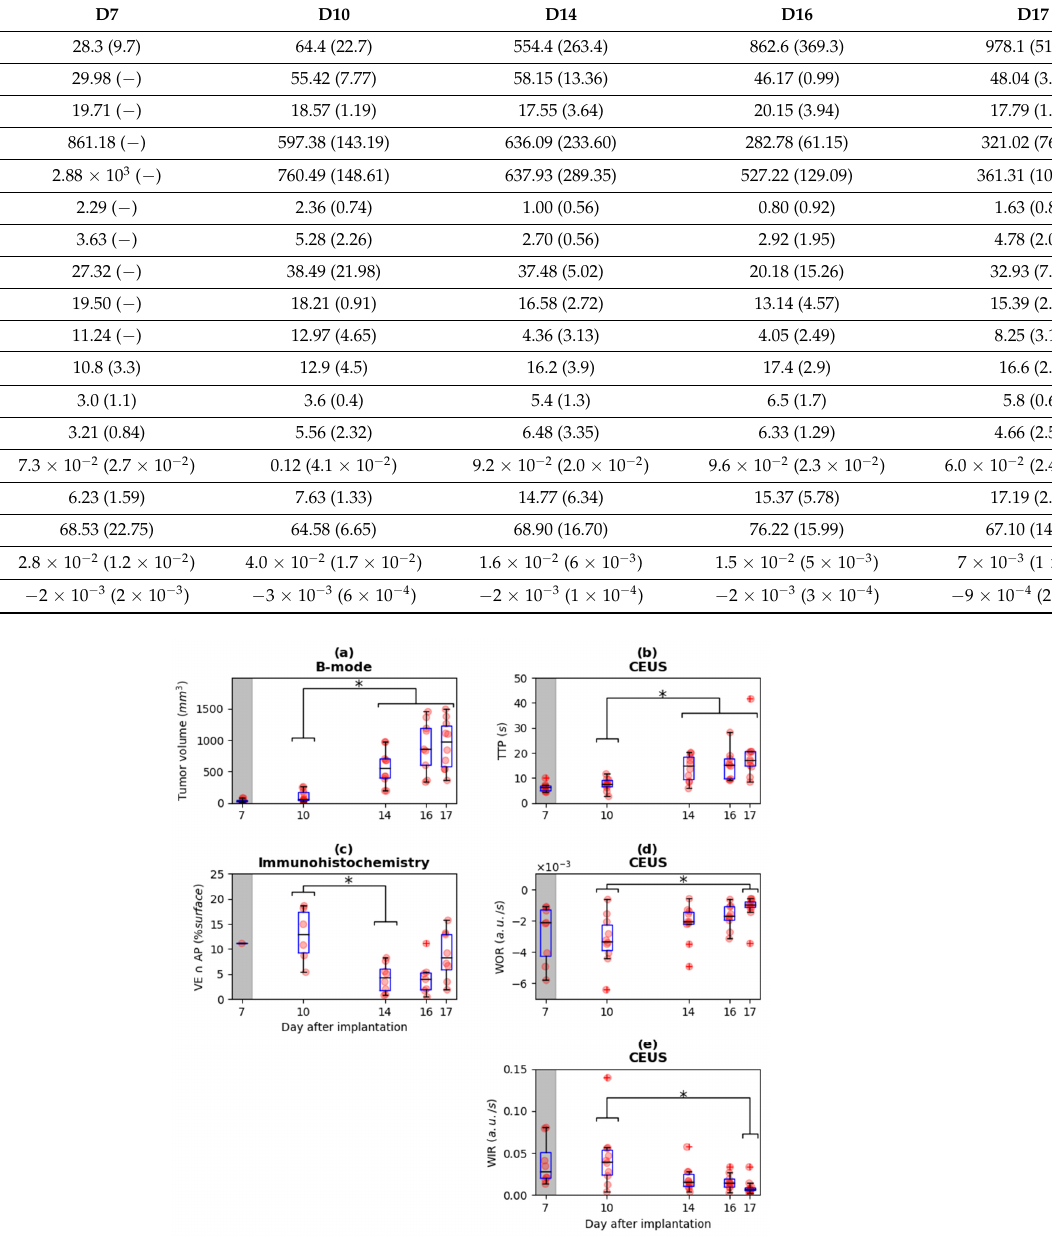
Figure 2. Evolution over time of ( a ) tumor volume, ( b ) Time To Peak (TTP), ( c ) colocalization of apoptosis and vascular endothelium (VE ∩ AP), ( d ) Wash-Out Rate (WOR), and ( e ) Wash-In Rate (WIR). For tumor volume ( a ) and the contrast parameters TTP ( b ), the values at D10 are significantly different to the values at D14, D16, and D17. The immunohistological parameter VE ∩ AP ( b ) shows significant difference between D10 and D14. The contrast parameters WOR ( d ) and WIR ( e ) show significant differences between D10 and D17. Initial measurements at D7 are shaded in grey because previous studies in this model suggest that the tumor fragment is not yet biologically integrated into the host prior to D9. The raw data and associated boxplot are overlaid; * = p < 0.05, + =